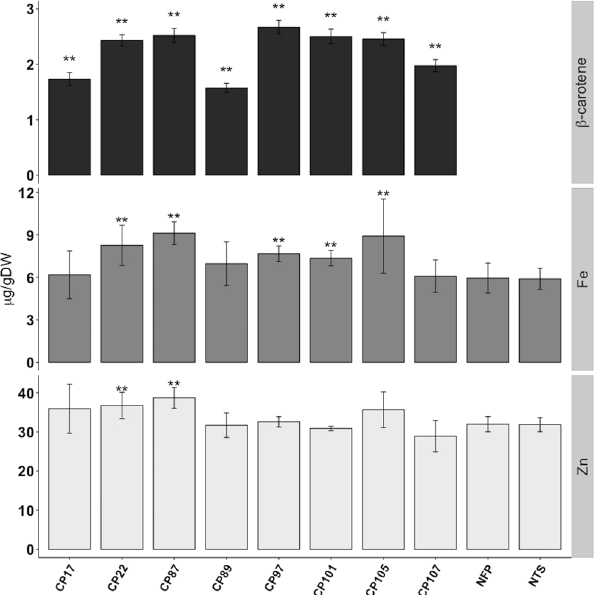
Figure 2. β -carotene and metal content of CP lines. β -carotene, iron (Fe) and zinc (Zn) content in polished grains of T3 CP lines. Values are the mean of three biological replicates ( ± SD). Black asterisks above the bars indicate statistically significant differences calculated using Student’s T test in comparison to the control line NFP ( * P < 0.05; ** P < 0.01). NTS is the segregating NFP sibling that does not contain the PaCRTI - ZmPSY